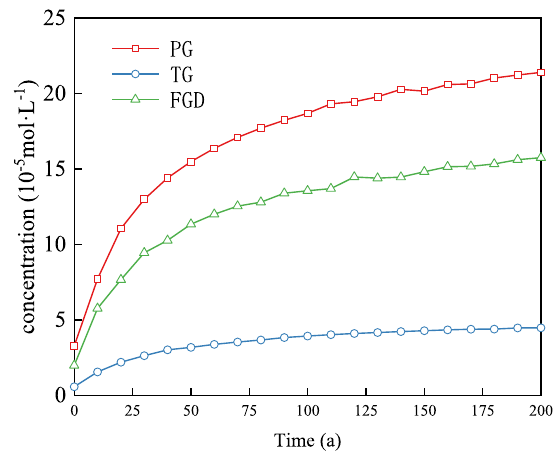
Fig. 6 Zn concentration distribution curves at the observation point over time (10 −5 mol/L)